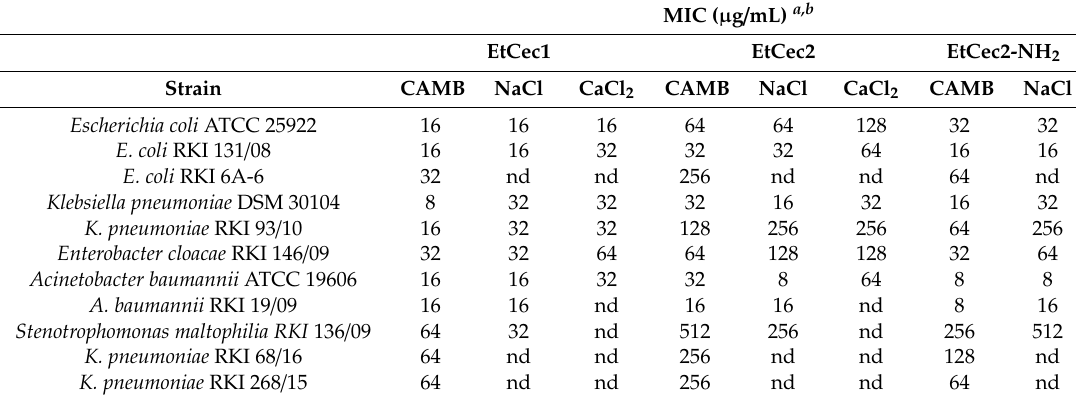
Table 4. Antibacterial activity of the Eristalis tenax AMPs under simulated physiological conditions a